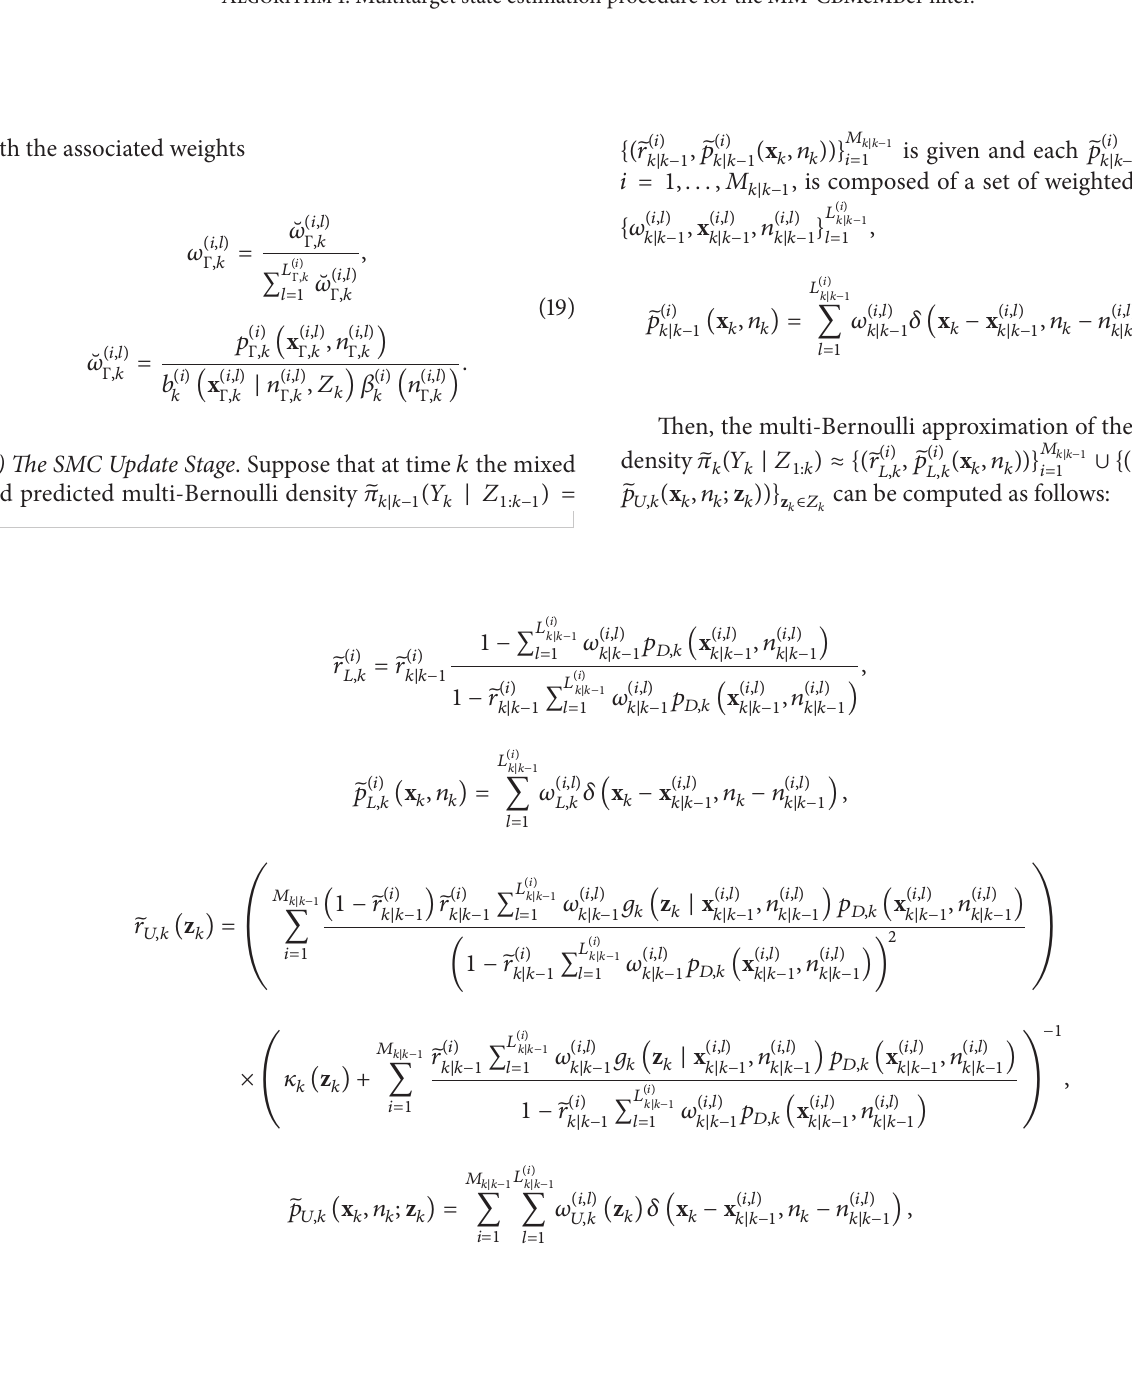
Algorithm 1: Multitarget state estimation procedure for the MM-CBMeMBer